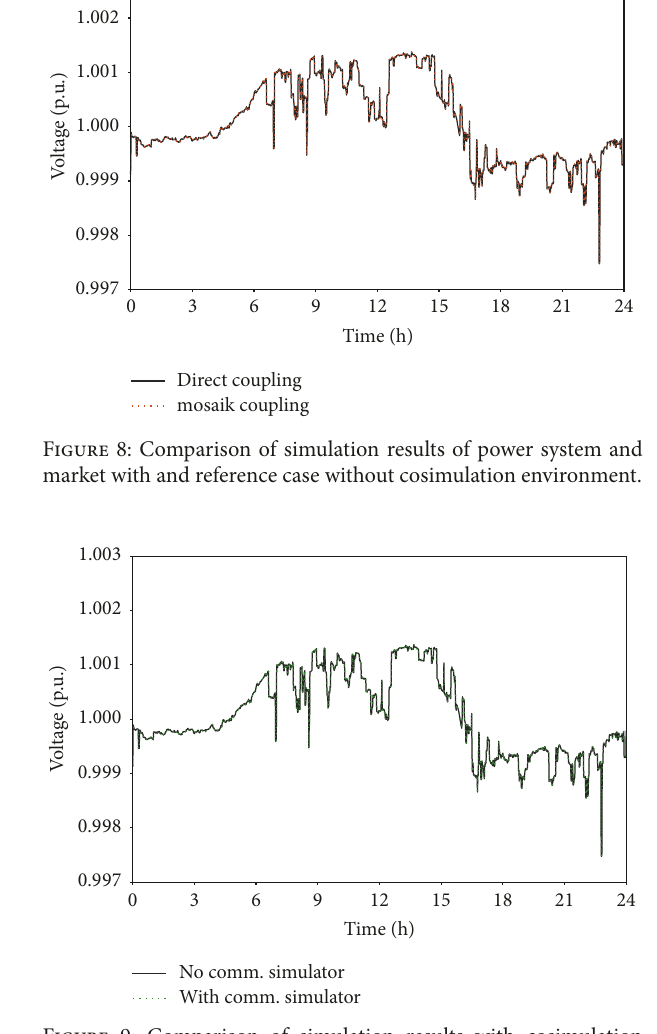
Figure 9: Comparison of simulation results with cosimulation environment and ideal communication network and reference case without cosimulation